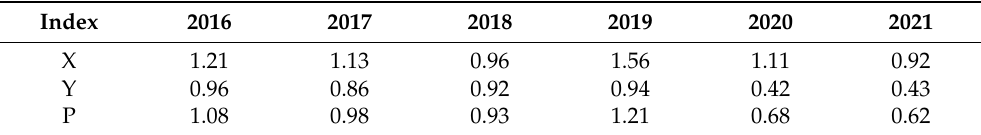
Table 7. Water quality evaluation results of surface water in the source region of the Yangtze River from 2016 to 2021 by Yao Zhiqi